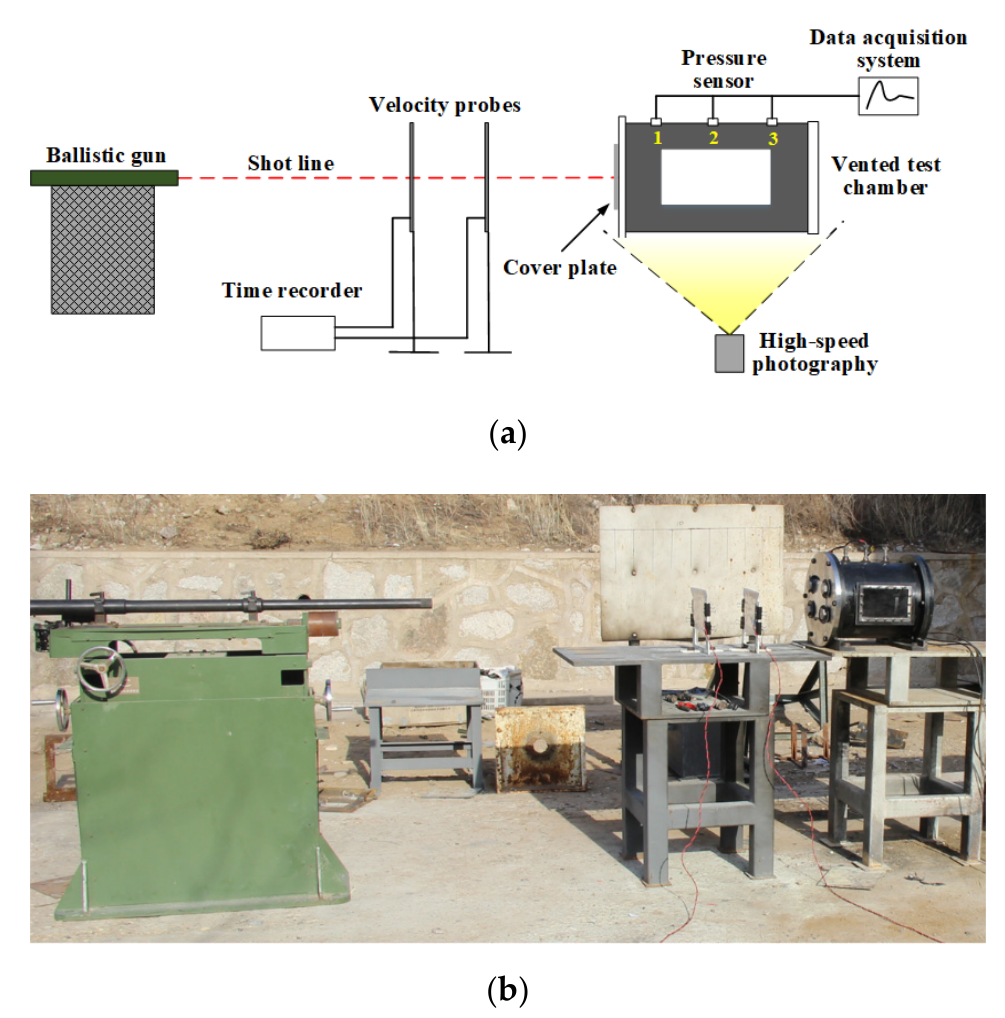
Figure 2. Schematic and physical photograph of experimental setup: ( a ) schematic; ( b ) physical pho- tograph.